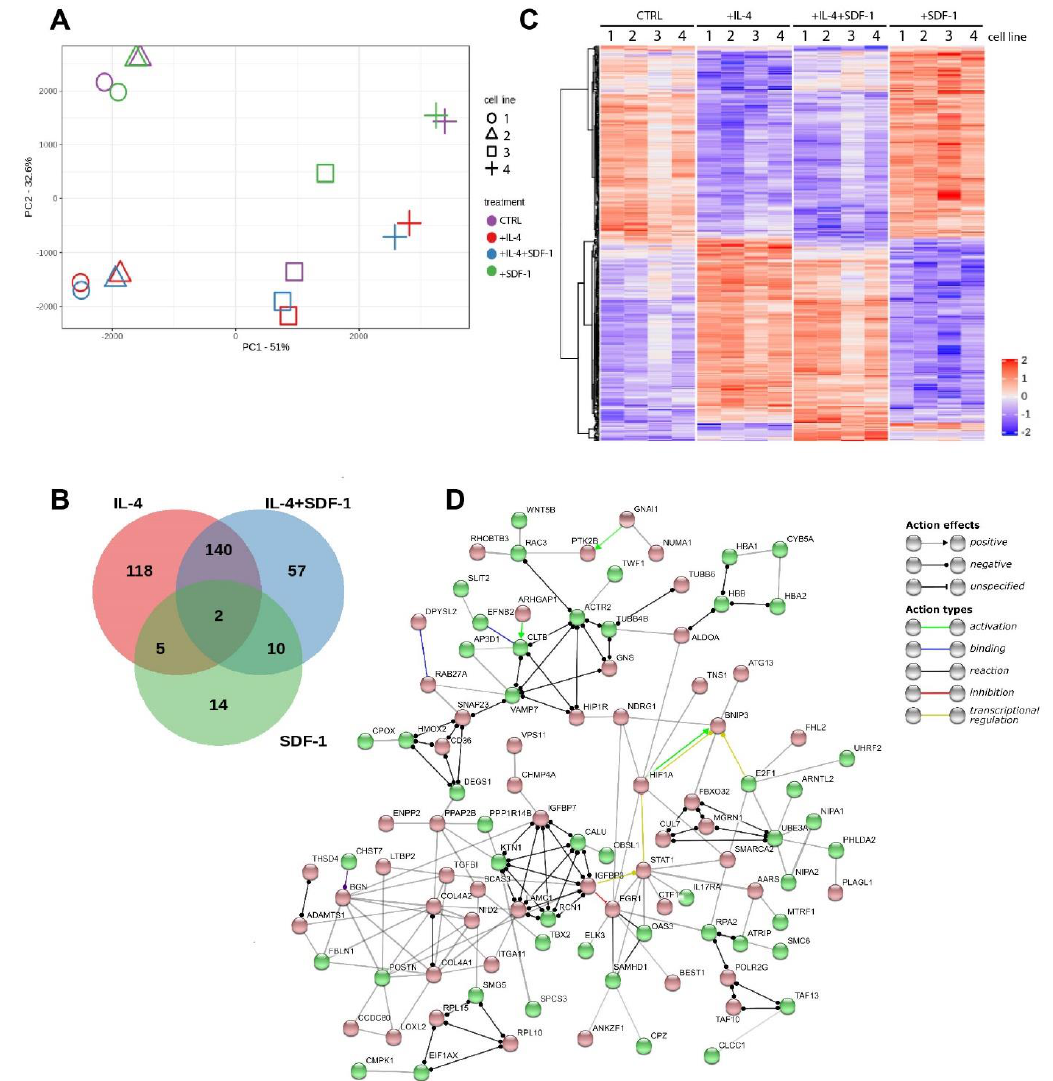
Figure 8. Global expression of mRNA in hADSCs cultured under control conditions or in the presence of IL-4, SDF-1, or IL-4 and SDF-1. ( A ) Principal component analysis (PCA) of four independent hADSCs. ( B ) Venn graph for 372 genes with a genome-wide significance (FDR < 0.005) from one-way ANOVA for the factor of treatment. Red circle shows genes affected by the IL-4 treatment, green by the SDF-1 treatment, and blue by the IL-4 and SDF-1 treatment. ( C ) Hierarchical clustering of transcripts regulated in response to treatment. RNA-seq results are shown as a heat map and include 372 genes with a genome-wide significance (FDR < 0.005) from one-way ANOVA for the factor of treatment. The intensity of the color is proportional to the standardized values (between −2 and 2) from each RNA-seq measurement, as indicated on the bar on the right of the heat map image. Hierarchical clustering was performed with R software using distance metrics correlation and the average linkage method. ( D ) Gene network for genes affected by the IL-4 and SDF-1 treatment. The network was created using STRING software and database. It shows protein–protein interaction. Up-regulated genes are marked in red and down-regulated in green.